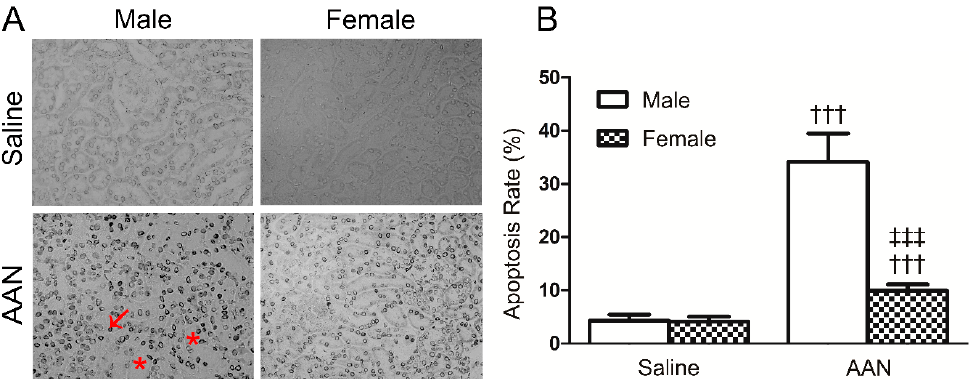
Figure 3. AA-induced RTEC apoptosis in mice at day 5. ( A ) RTEC apoptosis in acute AAN mice as